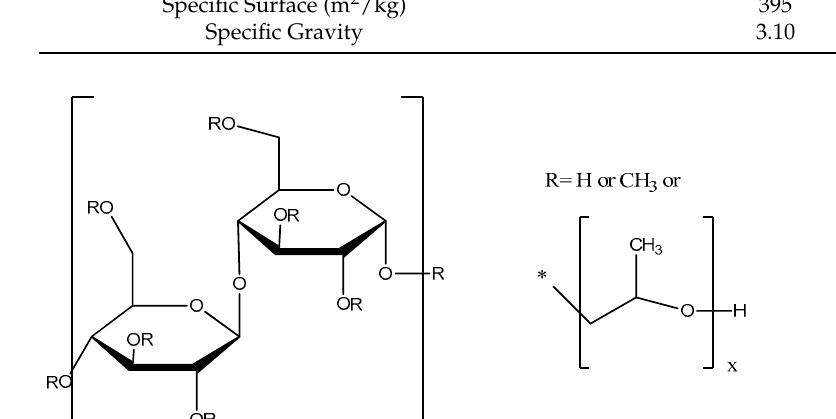
Figure 2. The generalized molecular structure of HPMC.